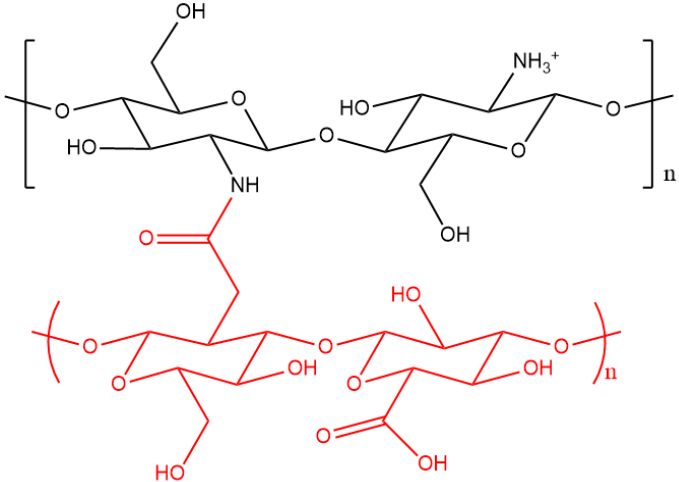
Figure 6. Structure of chitosan functionalised with hyaluronic acid (shown in red).